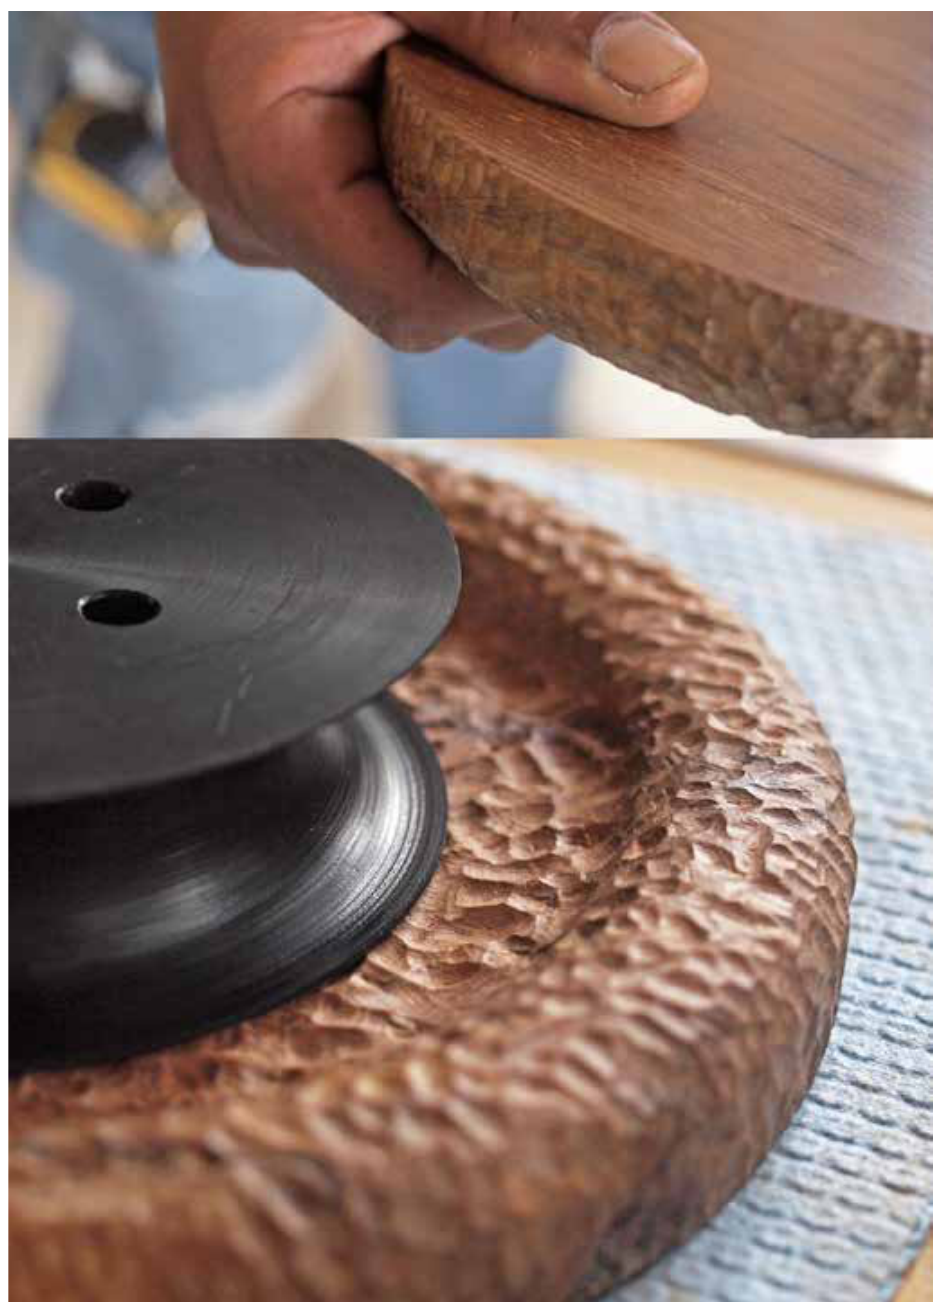
Figure 9: Traces of wear. Texture detail of hand chiselled back lip and hand polished front surface of a teak door handle. Source: